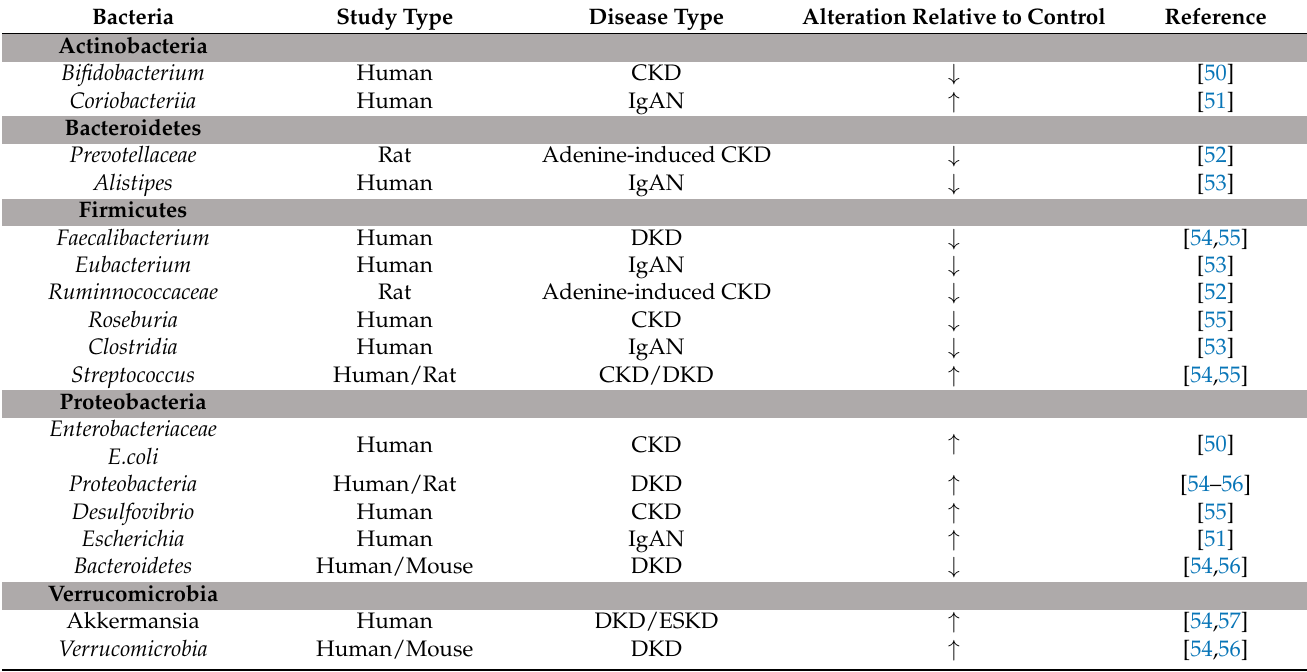
Table 1. Recent pre-clinical and clinical studies on the gut microbial composition in